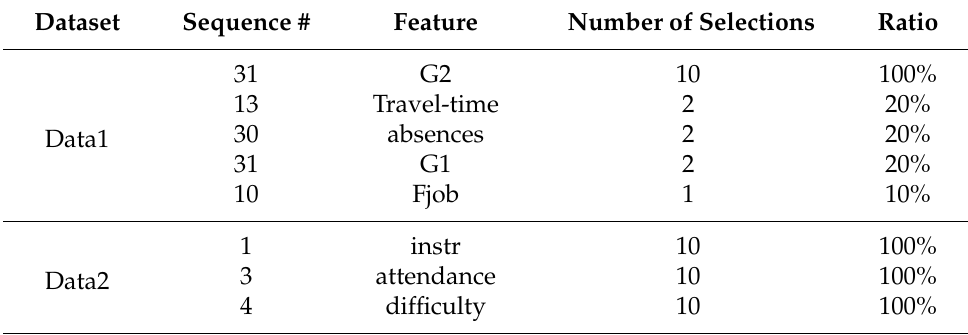
Table 16. The most relevant features selected by EWOA-V4 based on the total number of selections over 10 independent